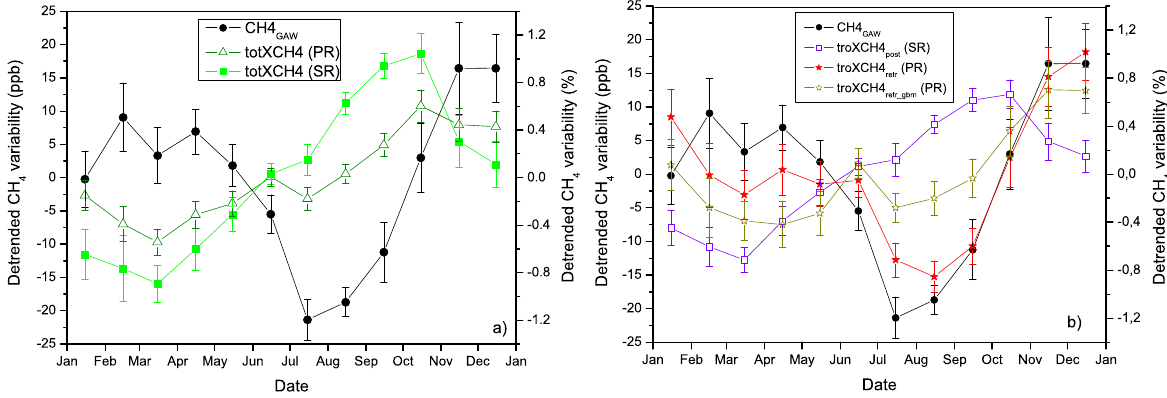
Fig. 12. The multi-annual mean annual cycles derived for data of the 2001–2010 period for the different CH 4 FTIR products: (a) total XCH 4 products; green squares for SR and green dark open triangles for PR; (b) tropospheric XCH 4 products: violet open squares for troXCH 4 , red stars for troXCH 4 and open dark yellow stars for troXCH 4 post retr standard error of the mean [2 x STD/sqrt( N)